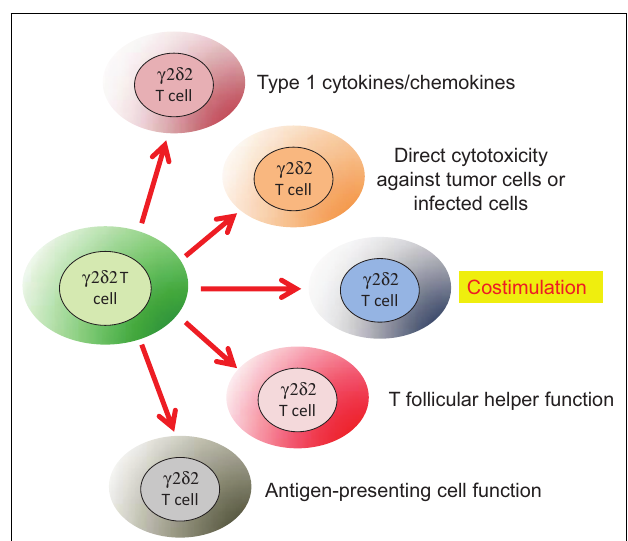
FIGURE 3 | Some of the known functions for humanV δ 2T cells that are related to HIV infection . NaïveV δ 2T cells can be stimulated to produce Type 1 cytokines/chemokines for antiviral immunity (47) or display potent lytic effect function against tumor cells (82, 83) or infected cells (47).V δ 2T cells also provide and receive costimulation from both NK cells (86) and dendritic cells (87).They display some similarity toT follicular helper cells required for B cell responses (85) and can function as antigen-presenting cells